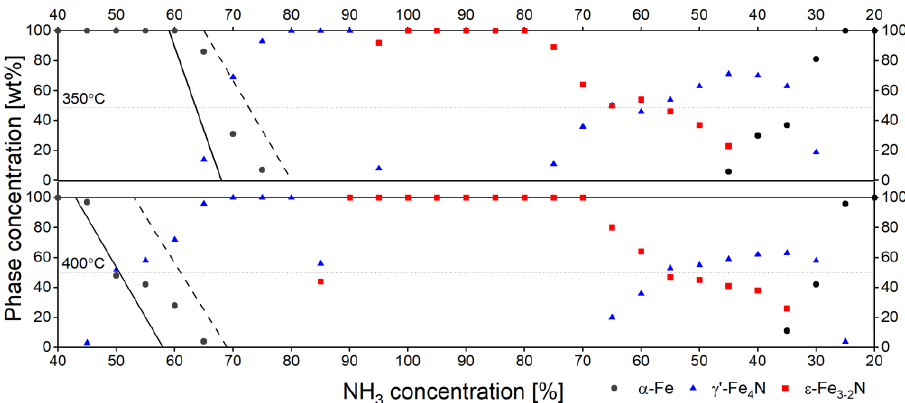
Figure 3. The evolution of α-Fe, γ’-Fe 4 N and ε-Fe 3-2 N phase composition of the sample during nitriding and denitriding processes studied at 350 and 400 °C. Solid (sample A) and dashed (sample B) black lines show the α-Fe concentration during α-Fe to γ’-Fe 4 N phase transformation for the similar processes carried for sample A and B separately.